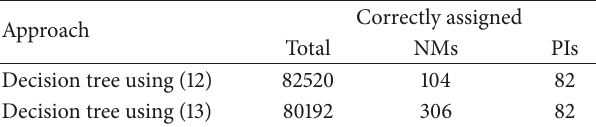
Table 12: Decision tree classification result using (12) and